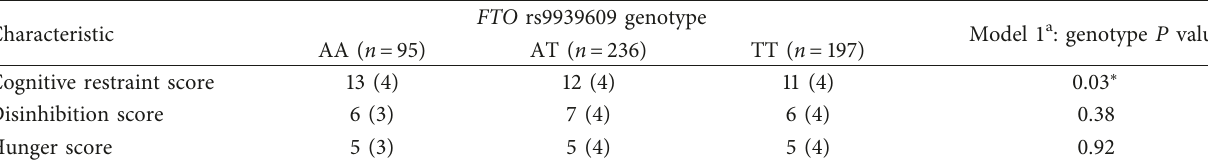
Values are mean (SD) for n � 528. Comparisons were made using linear mixed models adjusted for age and sex. ES, effect size. a Model 1: additive genotype model (AA versus ATversus TT). ∗ Significant difference between AA and TT FTO rs9939609 genotype (linear mixed model P < 0 . 05 after Holm–Bonferroni